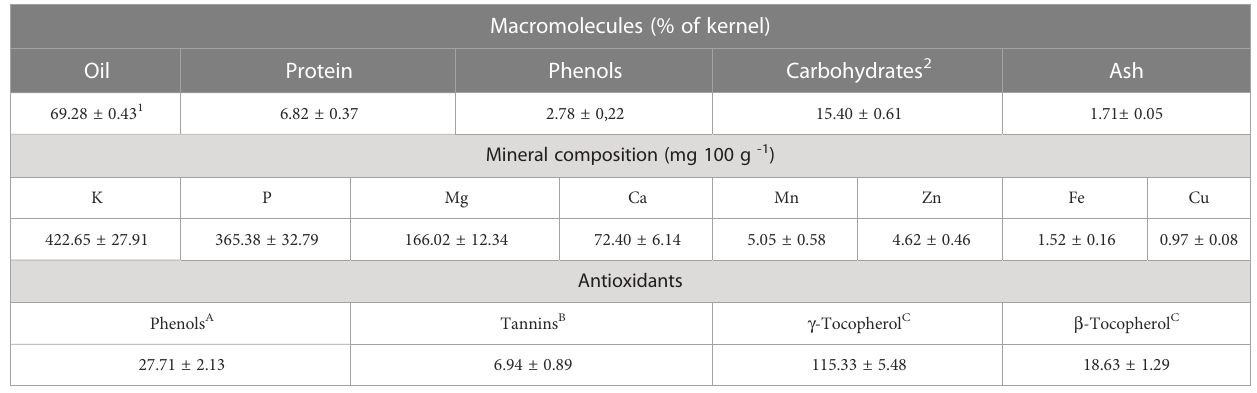
TABLE 1 Nutritional composition of the pecan kernel at 4%